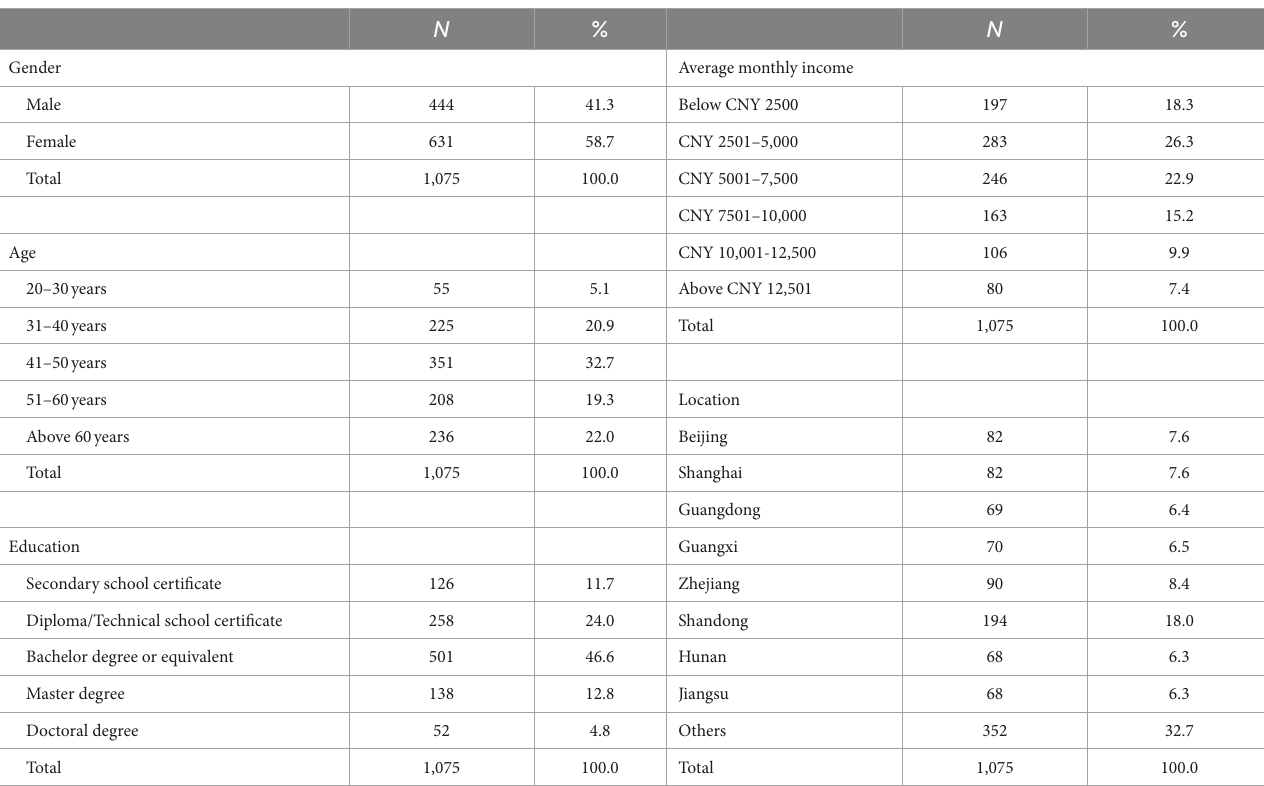
TABLE 2 Profile of the respondents.